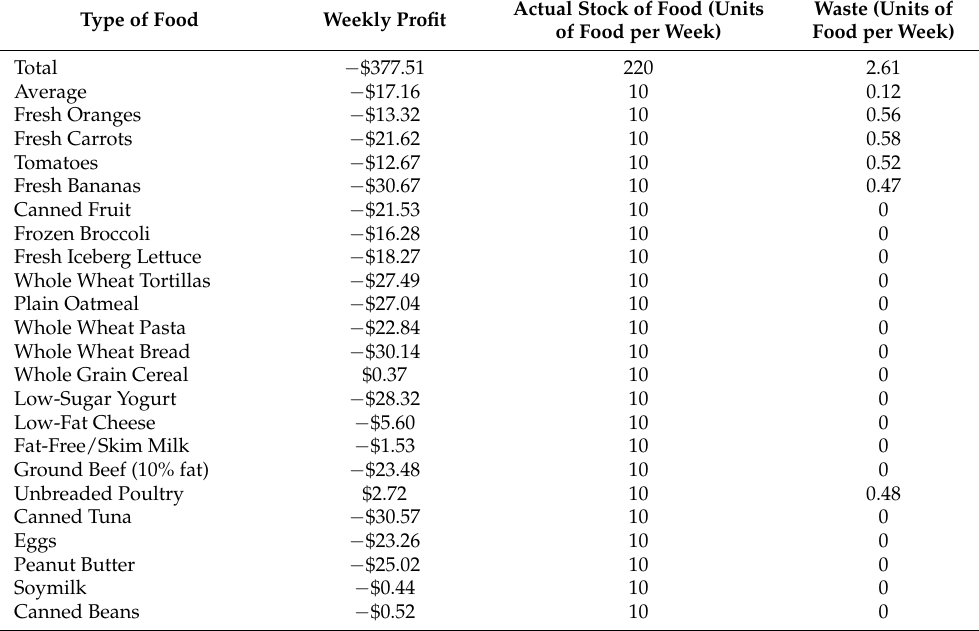
Table A2. Simulation Results for the SNAP Depth